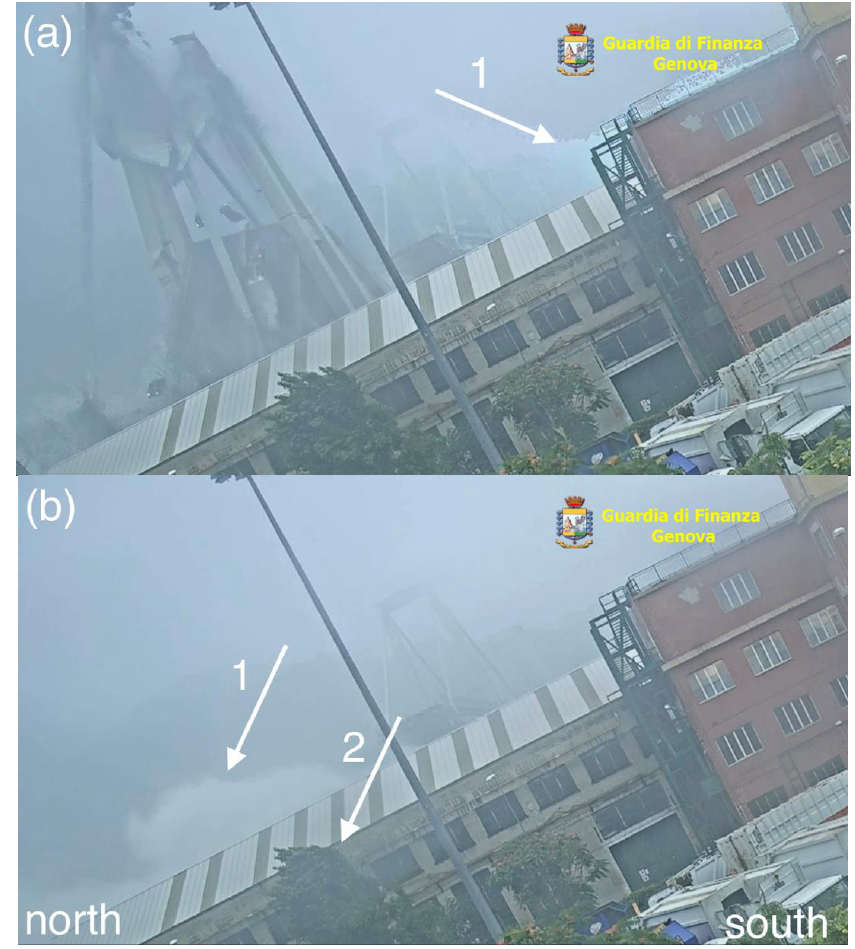
Figure 8. Two snapshots of the video that was recorded by a security camera located nearby and to the west of the bridge. The video was taken ( a ) during the collapse of Morandi Bridge and ( b ) immediately after the collapse. Arrow 1 in ( a ) indicates the lightning captured by the camera during the collapse. Arrow 1 and 2 in ( b ) show qualitatively the strength of wind that affects, respectively, the advection of dust and tilts the tree.